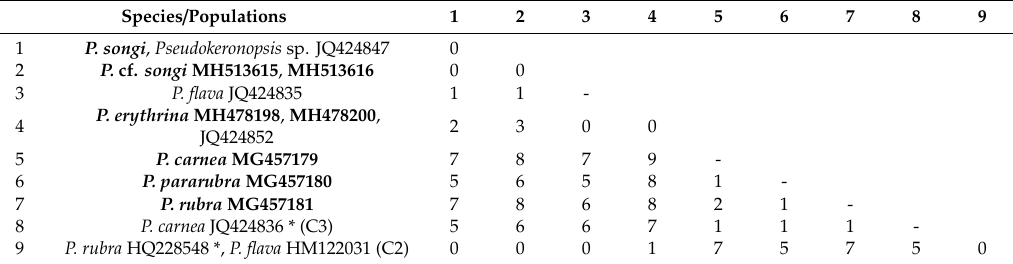
Table 4. Compensating base changes of LSU-D2 between Pseudokeronopsis species/populations. Species/Populations P. songi , Pseudokeronopsis sp. JQ424847